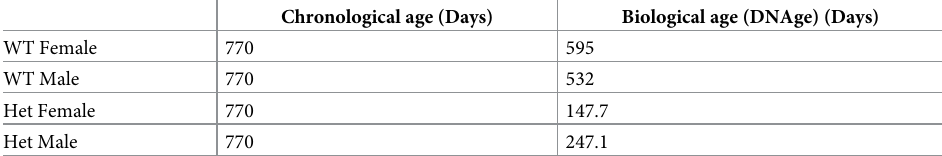
Table 2. Estimated biological age as determined by DNAge methylation clock.